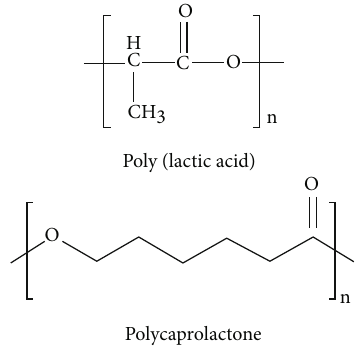
Figure 36: Structures of poly(lactic acid) and